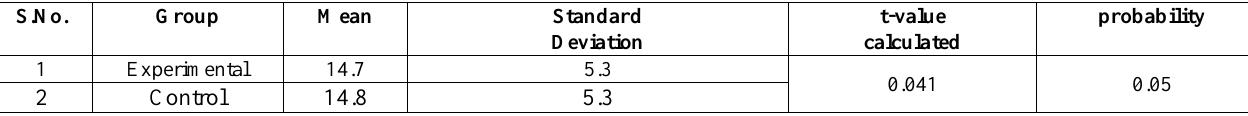
Table No 4.4: Mean Standard Deviation and t-value of Experimental and control groups on Pre-test.